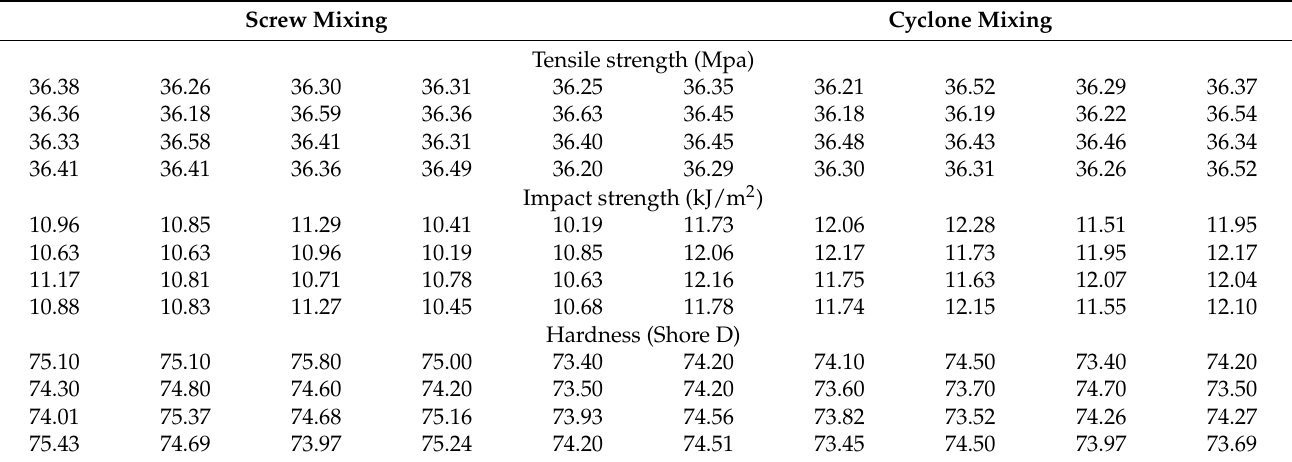
Table 8. Multi-quality process parameter optimization